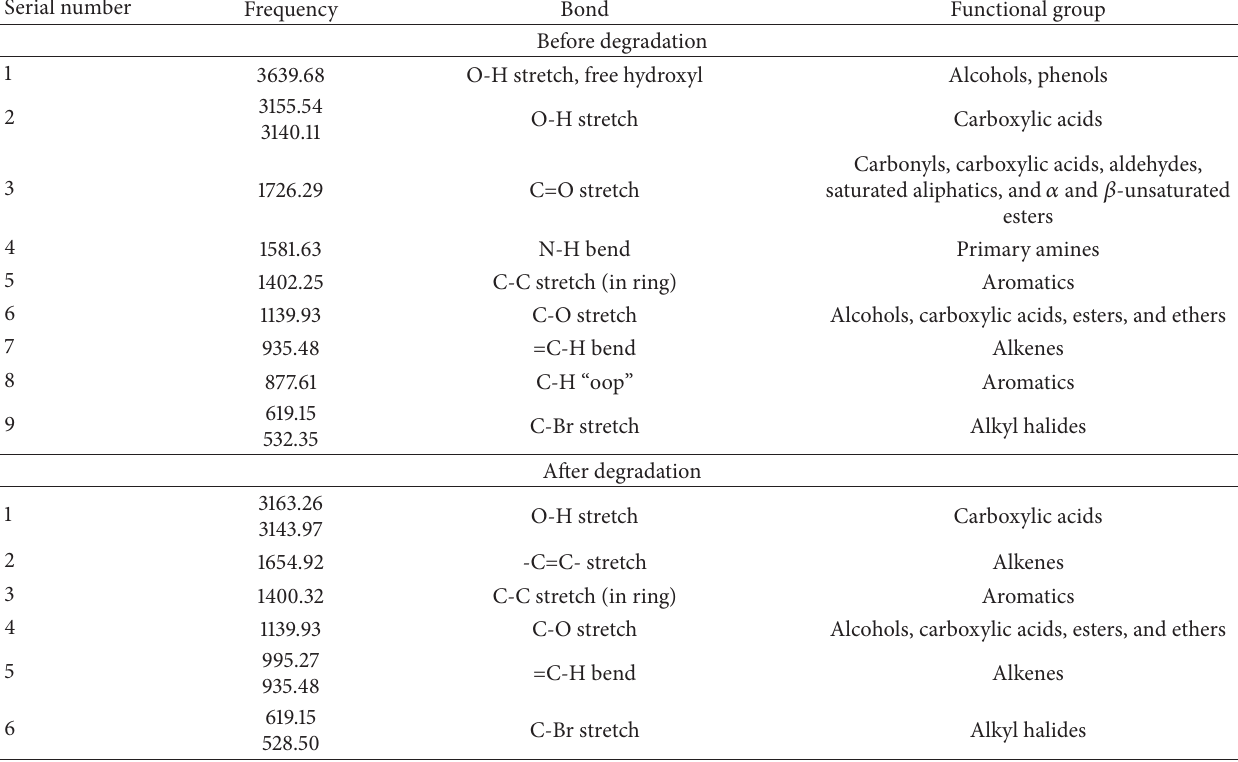
Table 5: Table showing frequencies visible in the spectra and their possible functional groups before and after degradation of